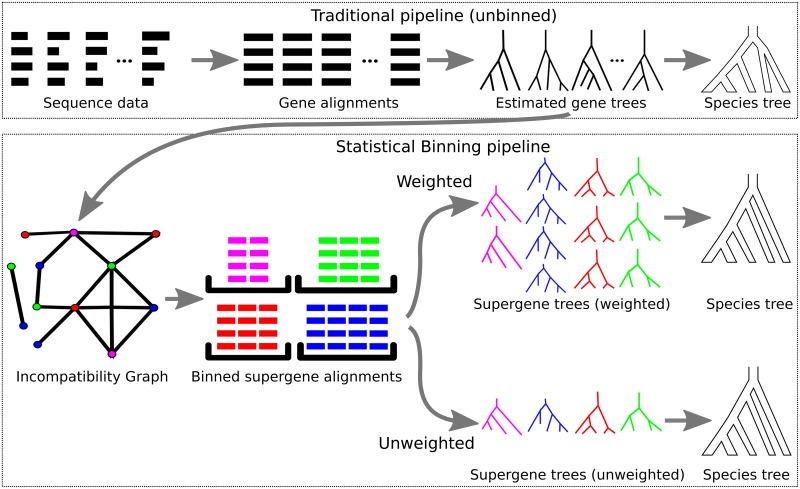
Pipeline for unbinned analyses, unweighted statistical binning, and weighted statistical binning.The input to the pipeline is a set of sequences for different loci across different species. In the traditional pipeline, a multiple sequence alignment and gene tree is computed for each locus, and then these are given to the preferred coalescent-based summary method, and a species tree is returned. In the statistical binning pipeline, the estimated gene trees are used to compute an incompatibility graph, where each vertex represents a gene, and an edge between two genes indicates that the differences between the trees for these genes is considered significant (based on the bootstrap support of the conflicting edges between the trees). The vertices of the graph are then assigned colors, based on a heuristic for balanced minimum vertex coloring, so that no edge connects two vertices of the same color. The vertices with a given color are put into a bin, and the sequence alignments for the genes in a bin are combined into a supergene alignment. A (supergene) tree is then computed for each supergene alignment using a fully partitioned analysis. In the unweighted binning approach (presented in [23]), these supergene trees are then given to the preferred summary method, and a species tree is returned. In the weighted binning approach presented here, each supergene tree is repeated as many times as the number of genes in its bin, and this larger set is then given to the preferred summary method.